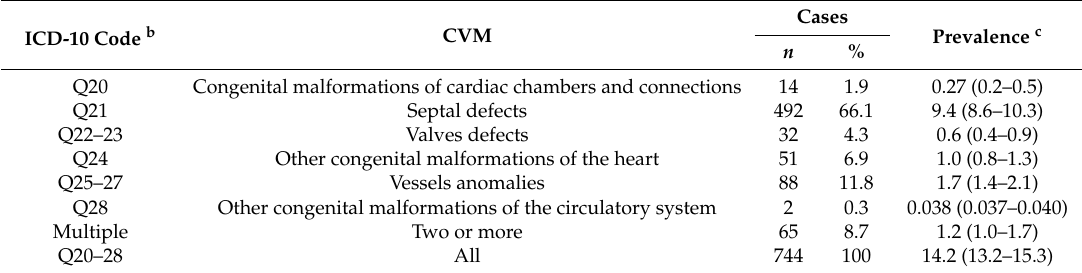
Table 1. Incidence and prevalence a of cardiovascular malformations (CVMs) for the combined data set of newborns registered in the Murmansk County Birth Registry (MCBR) and the Murmansk Regional Congenital Defects Registry (MRCDR) during the period 2006–2011.